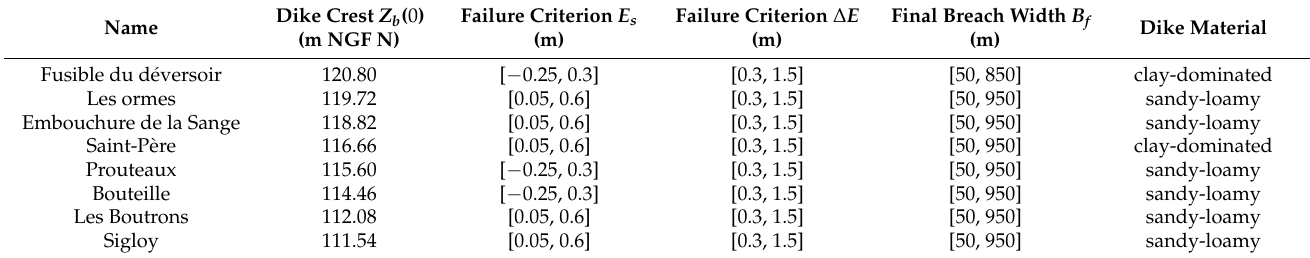
Table 2. Breach parameters with associated range of variations, based on measurement uncertainty or historical analysis with geotechnical characteristics [41,42] ( Failure Criterion E s and final breach width B f , respectively) or defined by expert knowledge ( energy balance criterion ∆ E